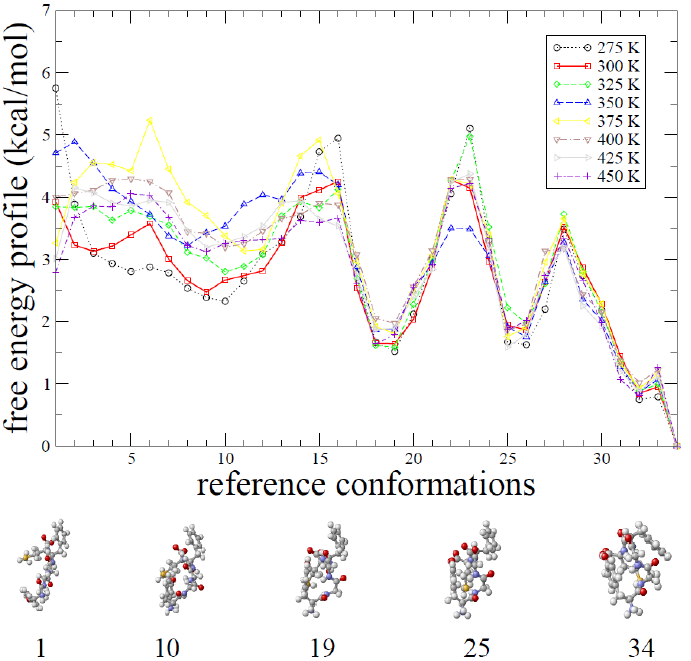
Figure 8. Free-energy profile obtained from REMD simulation based on the 34 “states” (or reference conformations) as described in text are shown. We take the reference energy of the free energy in such a way that its observed minimum is set to zero. Five reference conformations are also shown. The ground state (reference conformation 34) is favored thermodynamically and separated from the other low energy states by free-energy barriers. Reference conformation 1 is the fully extended conformation and marginally stable with a small free energy barrier of about 1 kcal/mol. Three reference conformations 10, 19 and 25 are metastable structures. For the free energy profile convergence test, we have carried out additional 50% of simulation time. The resulting two free energy profiles agree to each other within 1 kcal/mol.